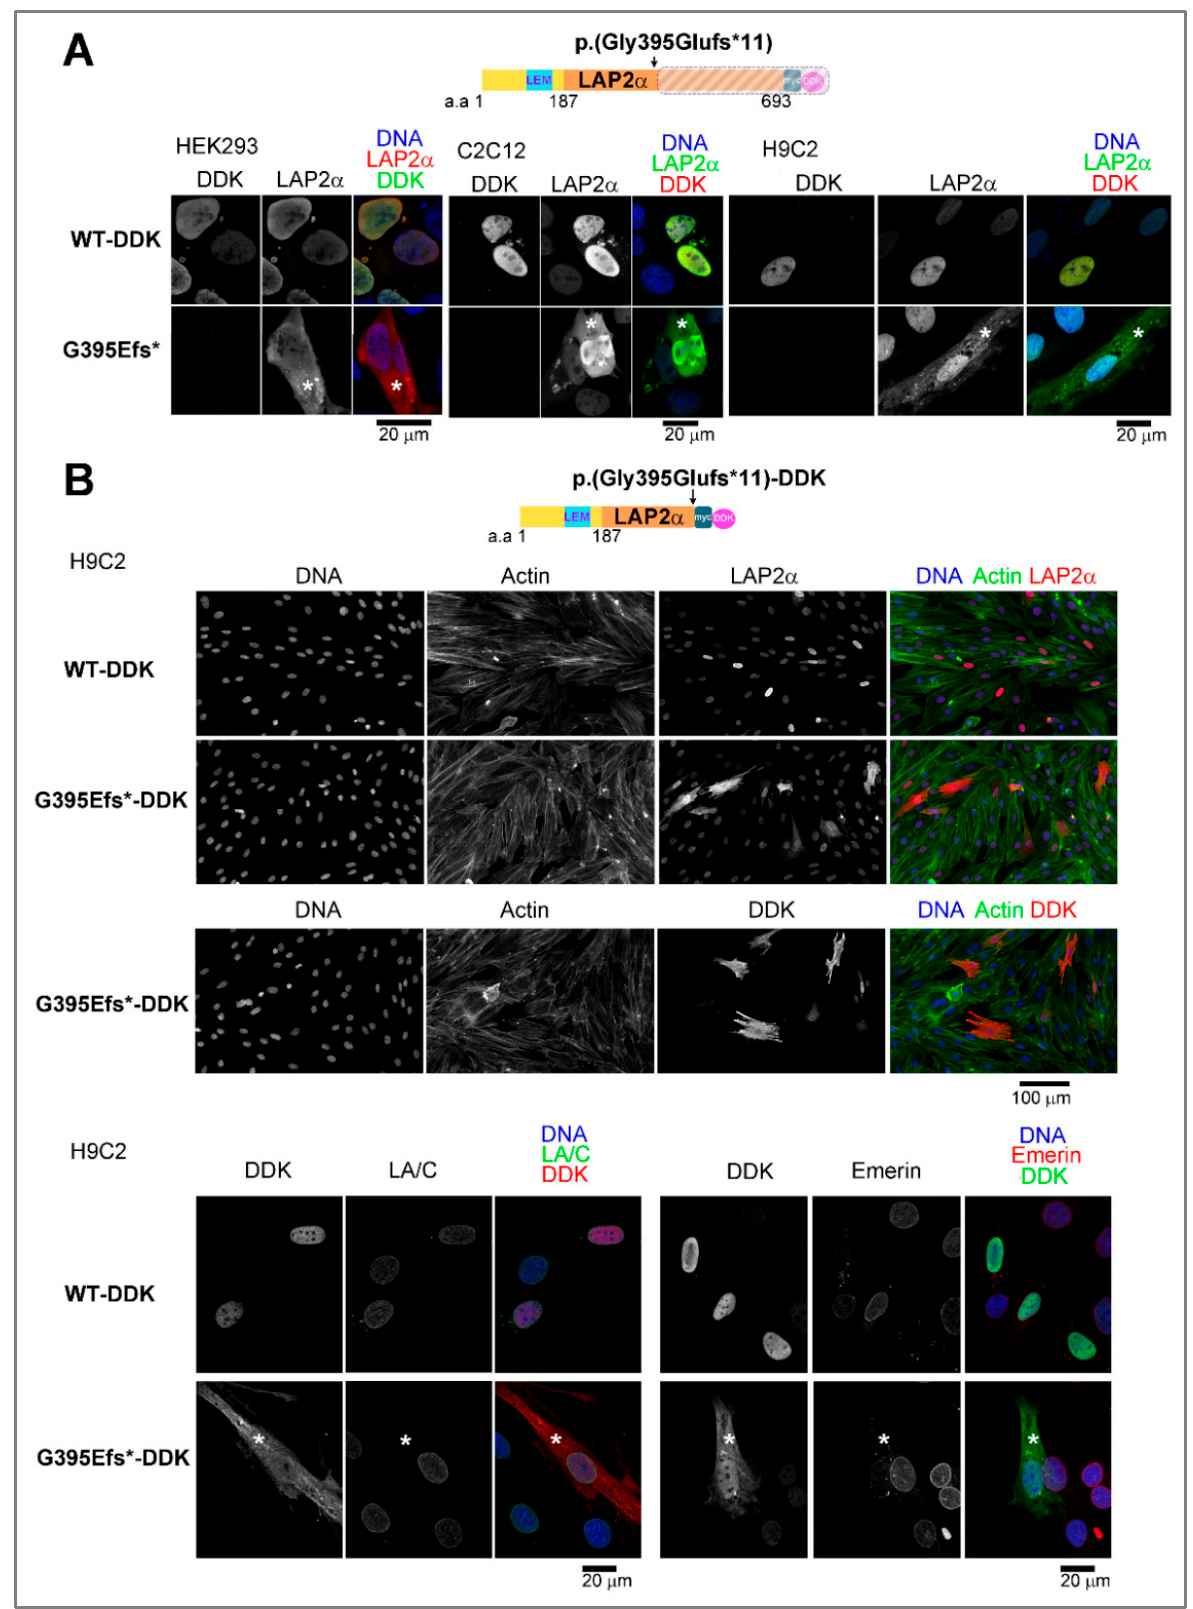
Figure 5. Abnormal cyto-nucleoplasmic distribution of the truncated LAP2 α variant. ( A ) HEK293, C2C12 and H9C2 cells overexpressing wild-type (WT-DDK) or mutant p.(Gly395Glufs*11) (G395E*) LAP2 α labeled with anti-DDK and anti-LAP2 α antibodies, as indicated. ( B ) H9C2 cells overexpress- ing WT-DDK or mutant G395E*-DDK LAP2 α were labeled with different mixtures of antibodies,